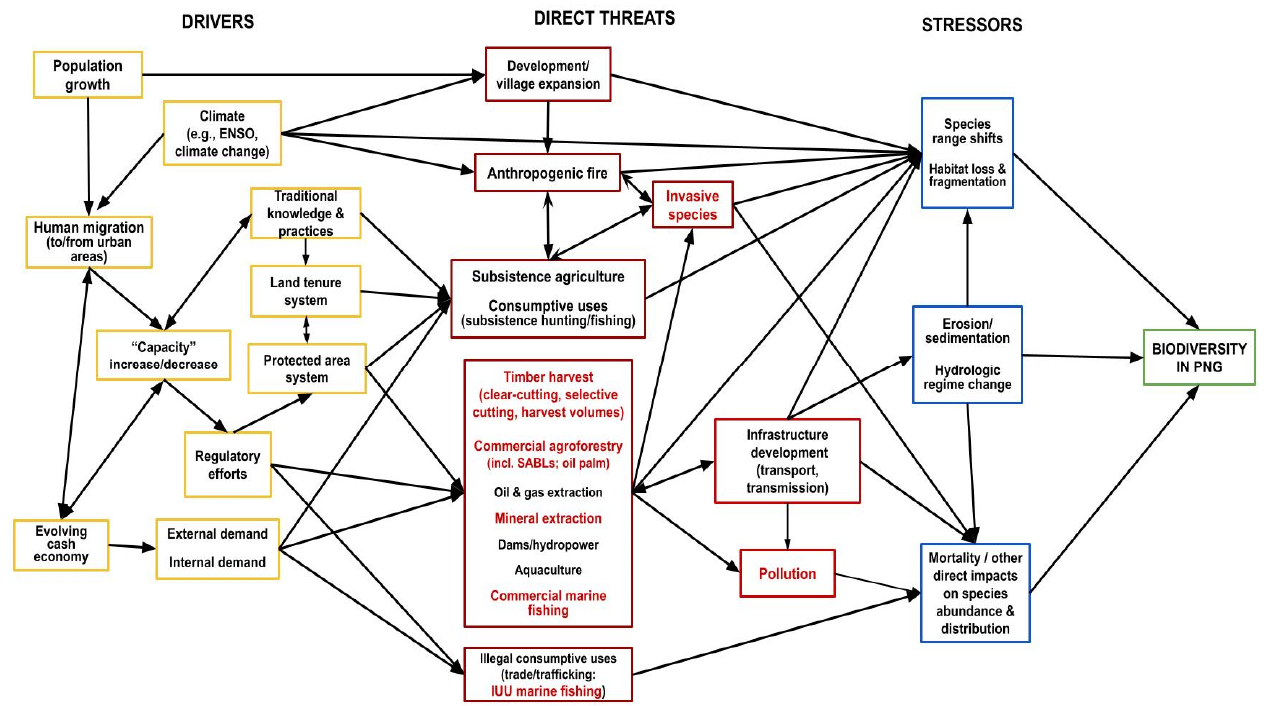
Figure 4. Situation Model based on quantitative assessment of biodiversity threats and associated drivers in Papua New Guinea. Bidirectional vectors represent interactions between component factors.